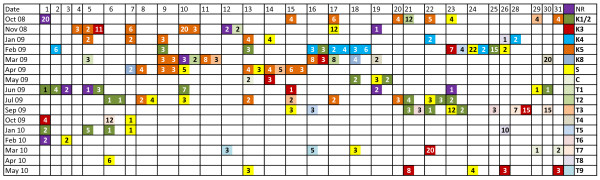
Distribution of failures to exclude 128 individual hairs over the dates of testing based on date of DNA extraction of each hair. Day of the month on the top line; on some days more than one sample was extracted. Dark colors are failures to exclude known individuals (K1-K5, K8). Lighter colors are types occurring more than one time (T1-T9) that do not match known individuals. Number within the box is size of hair in millimeters rounded up to the closest millimeter. C = canine, S = singleton types, NR = no results. Color key on the right.